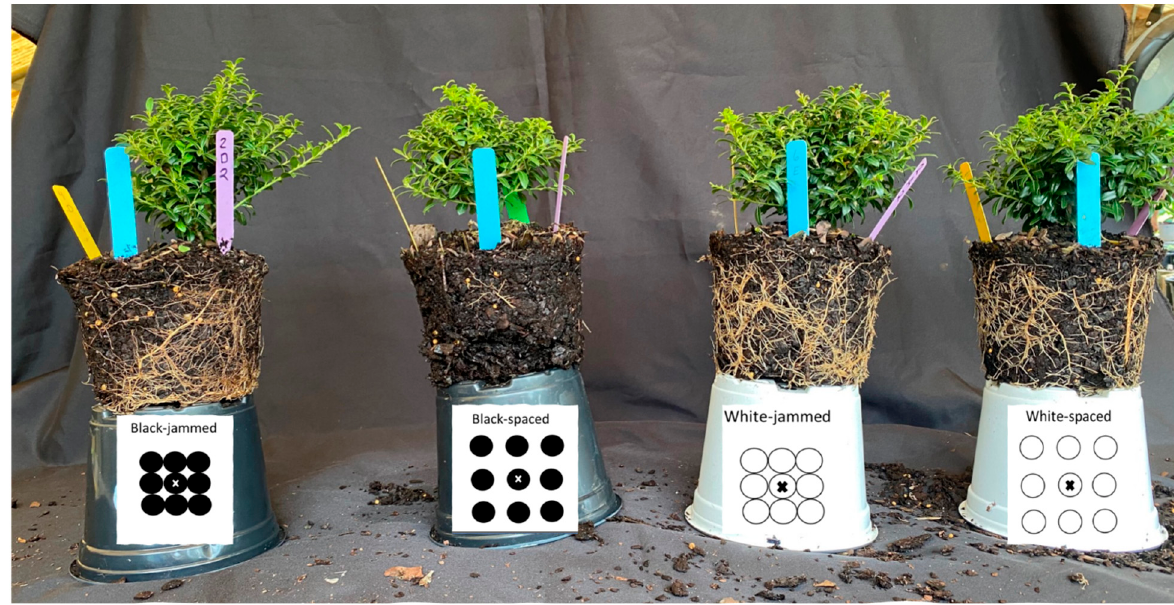
Figure 2. Example of root coverage (viewing south quadrant) for each treatment (left to right), black-jammed, black-spaced, white-jammed, and white-spaced.